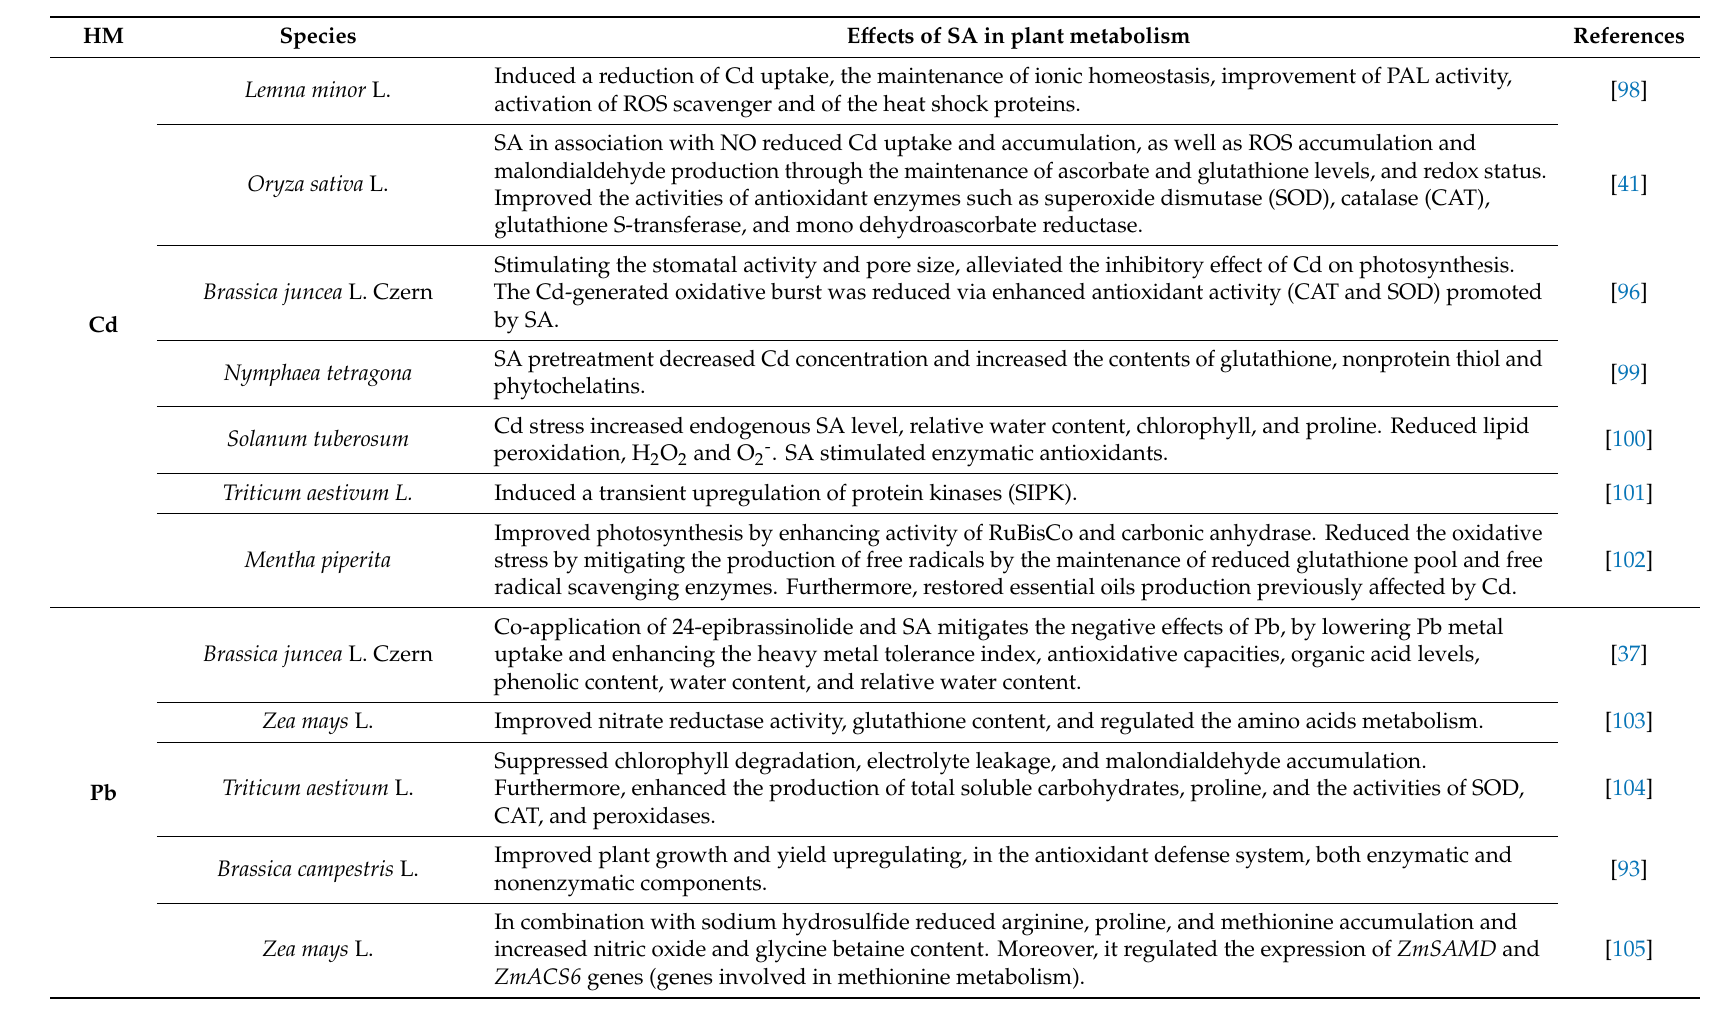
Table 1. Salicylic acid (SA) e ff ect on di ff erent heavy metals (HM) stressed